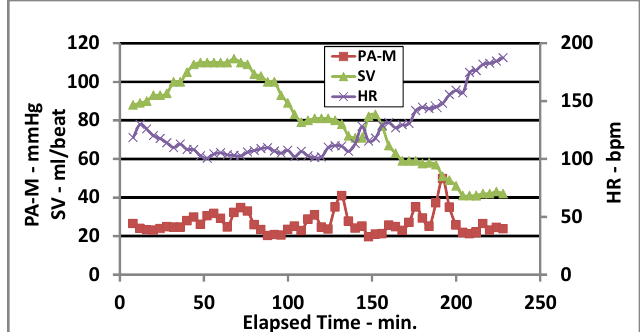
Figure 8. Mean pulmonary arterial pressure (PA-M), stroke volume (SV), and heart rate (HR) vs. elapsed time.